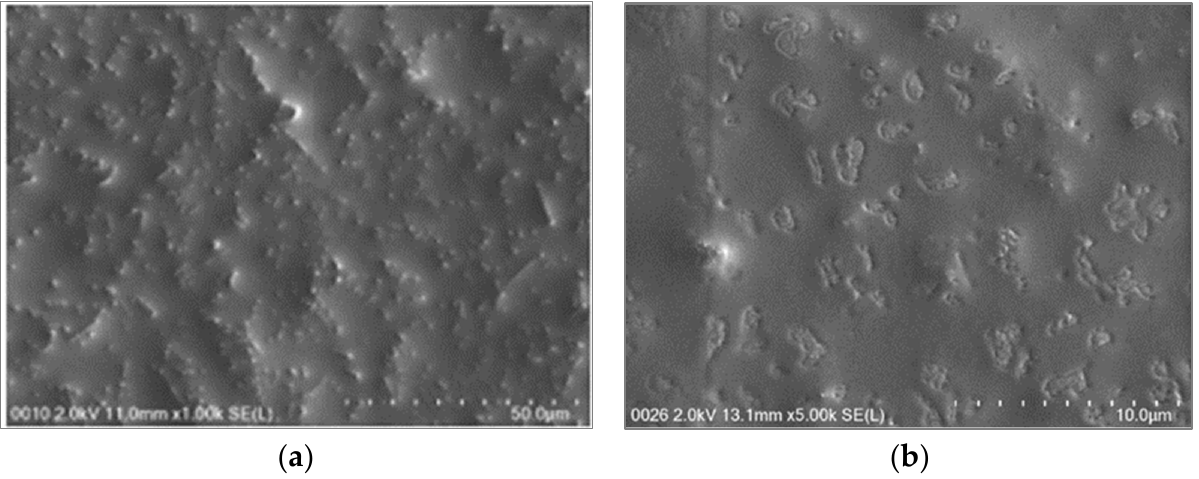
Figure 2. SEM images of NE-FLO in different conditions: ( a ) the SEM image taken at 1 kX magnification, ( b ) the SEM images taken at 5 kX magnification. The voltages used for both images are 2.0 kilovolts.